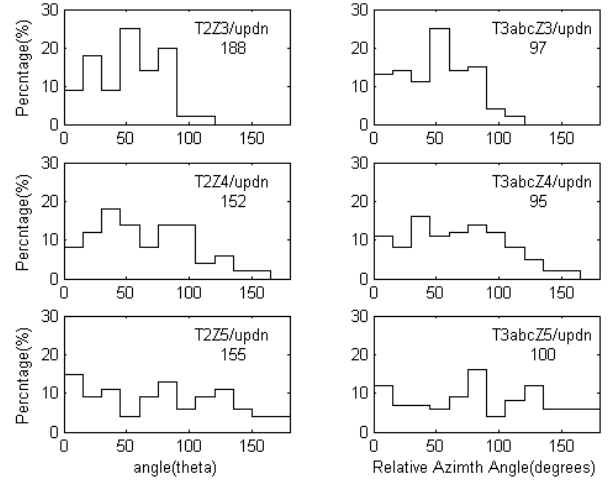
Fig.3 Same as Fig.2 except that the data was from the upward and downward moving Fig. 3. Same as Fig. 2 except that the data was from the upward and gravity wave packets of summer data set. downward moving gravity wave packets of summer data set.